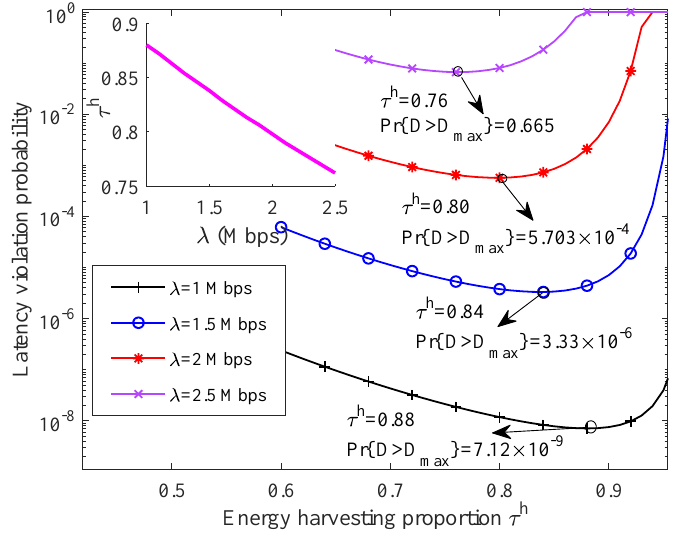
Figure 5. The relationship between network LVP and energy harvesting proportion under different data rate